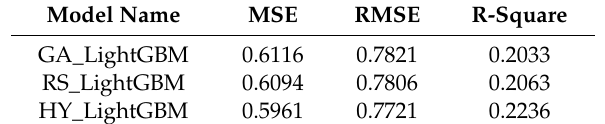
Table 7. Comparison of GA_LightGBM, RS_LightGBM, and HY_LightGBM.